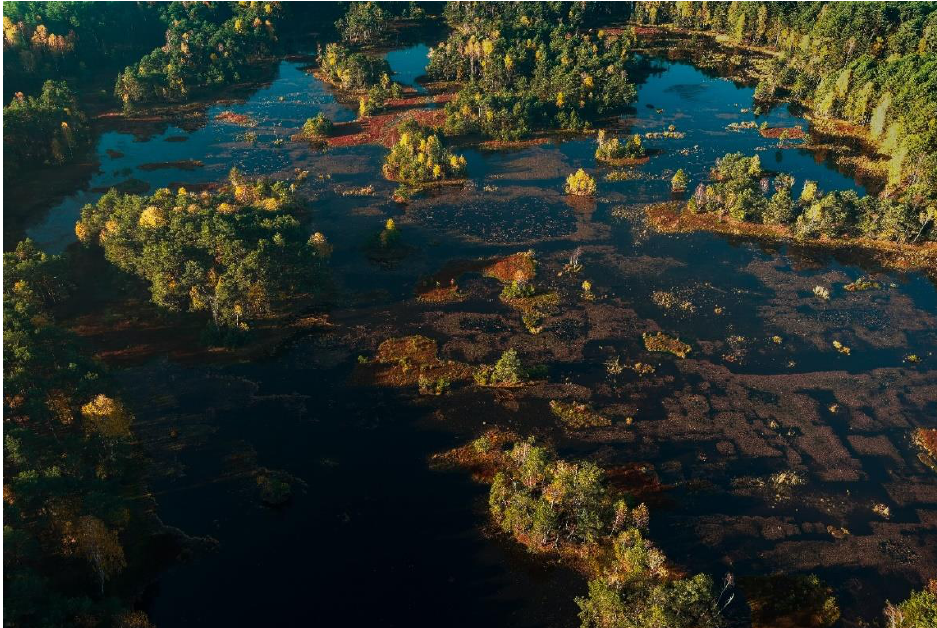
Figure 4. A drone image of post-exploitation peat reservoir 3.